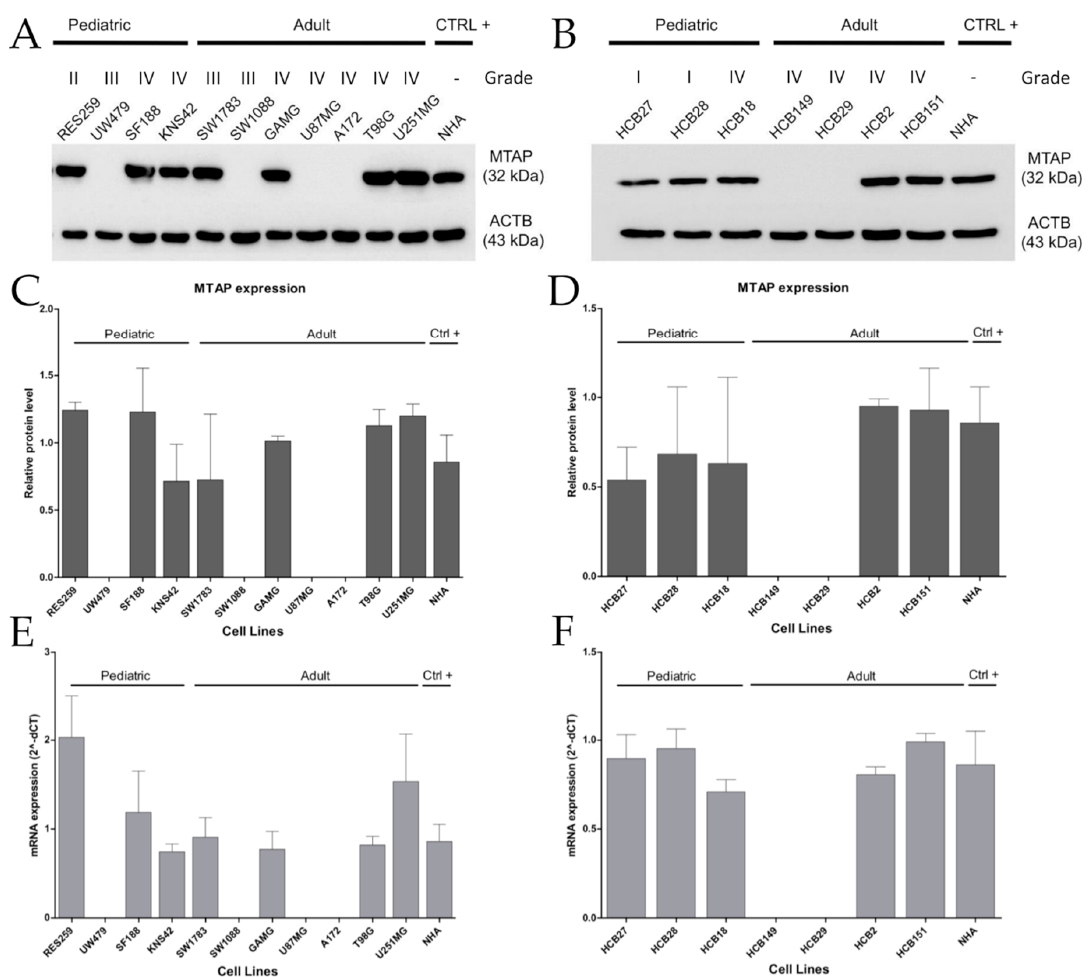
Figure 2. Loss of MTAP expression is more present in high-grade glioma (HGG) cell lines. MTAP protein expression analysis of established ( A ) and short-term primary glioma cells ( B ) assessed by Western blotting. Plot representative of MTAP protein ( C , D ) and gene ( E , F ) expression in glioma cell lines. Samples were normalized to HPRT-1 (mRNA) and beta-actin (ACTB) (protein) as an endogenous control. Abbreviations: CTRL+: positive control.